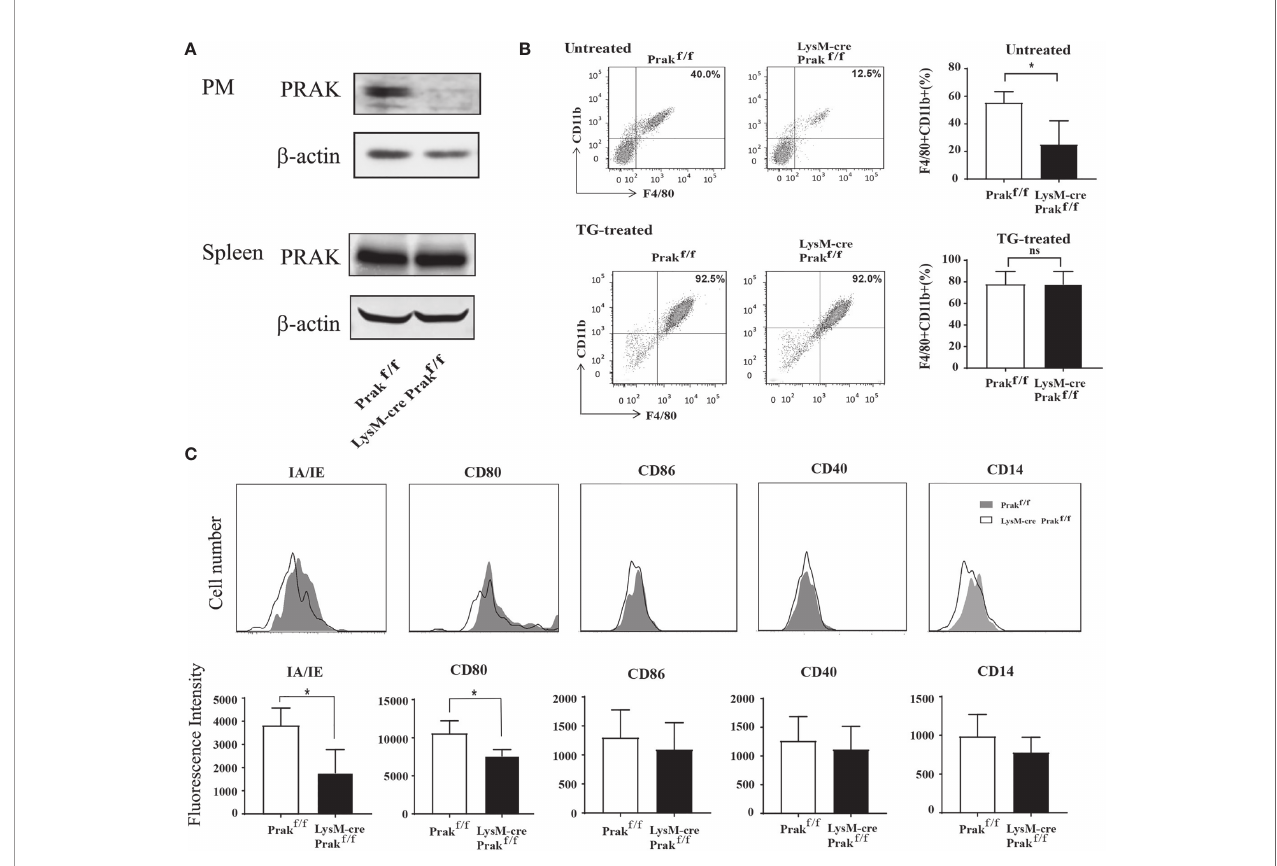
FIGURE 1 | Characterization of mice with Myeloid-speci fi c deletion of Prak. (A) Peritoneal macrophages (PM) and total splenocytes were collected from Prak knockout (KO, LysM -Cre Prak fl ox/ fl ox ) and wild type ( Prak fl ox/ fl ox ) mice. The expression of PRAK protein was detected by Western blotting. (B) Total cells in the peritoneal lavage from untreated and thioglycollate (TG)-treated mice were stained for CD11b and F4/80 expression. Representative dot plots are shown on the left and the percentage of CD11b + F4/80 + macrophages are presented as mean ± SD on the right (n=4 for each group). (C) Surface expression of MHC II, CD80, CD86, CD40 and CD14 in Prak -de fi cient and wild type peritoneal macrophages was analyzed by fl ow cytometry. Representative histograms from three independent experiments are shown in the top panel and the mean fl uorescence Intensity is presented as mean ± SD at the bottom. * P <0.05 by t -test. ns, not signi fi